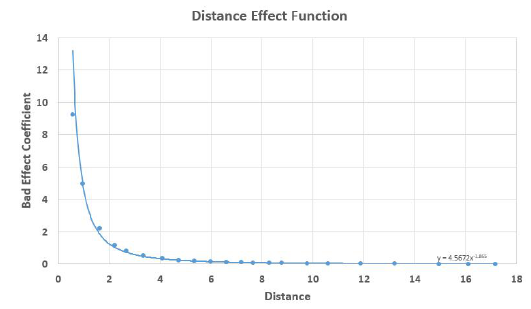
Figure 10. Curve of Distance Effect function ( − F e )